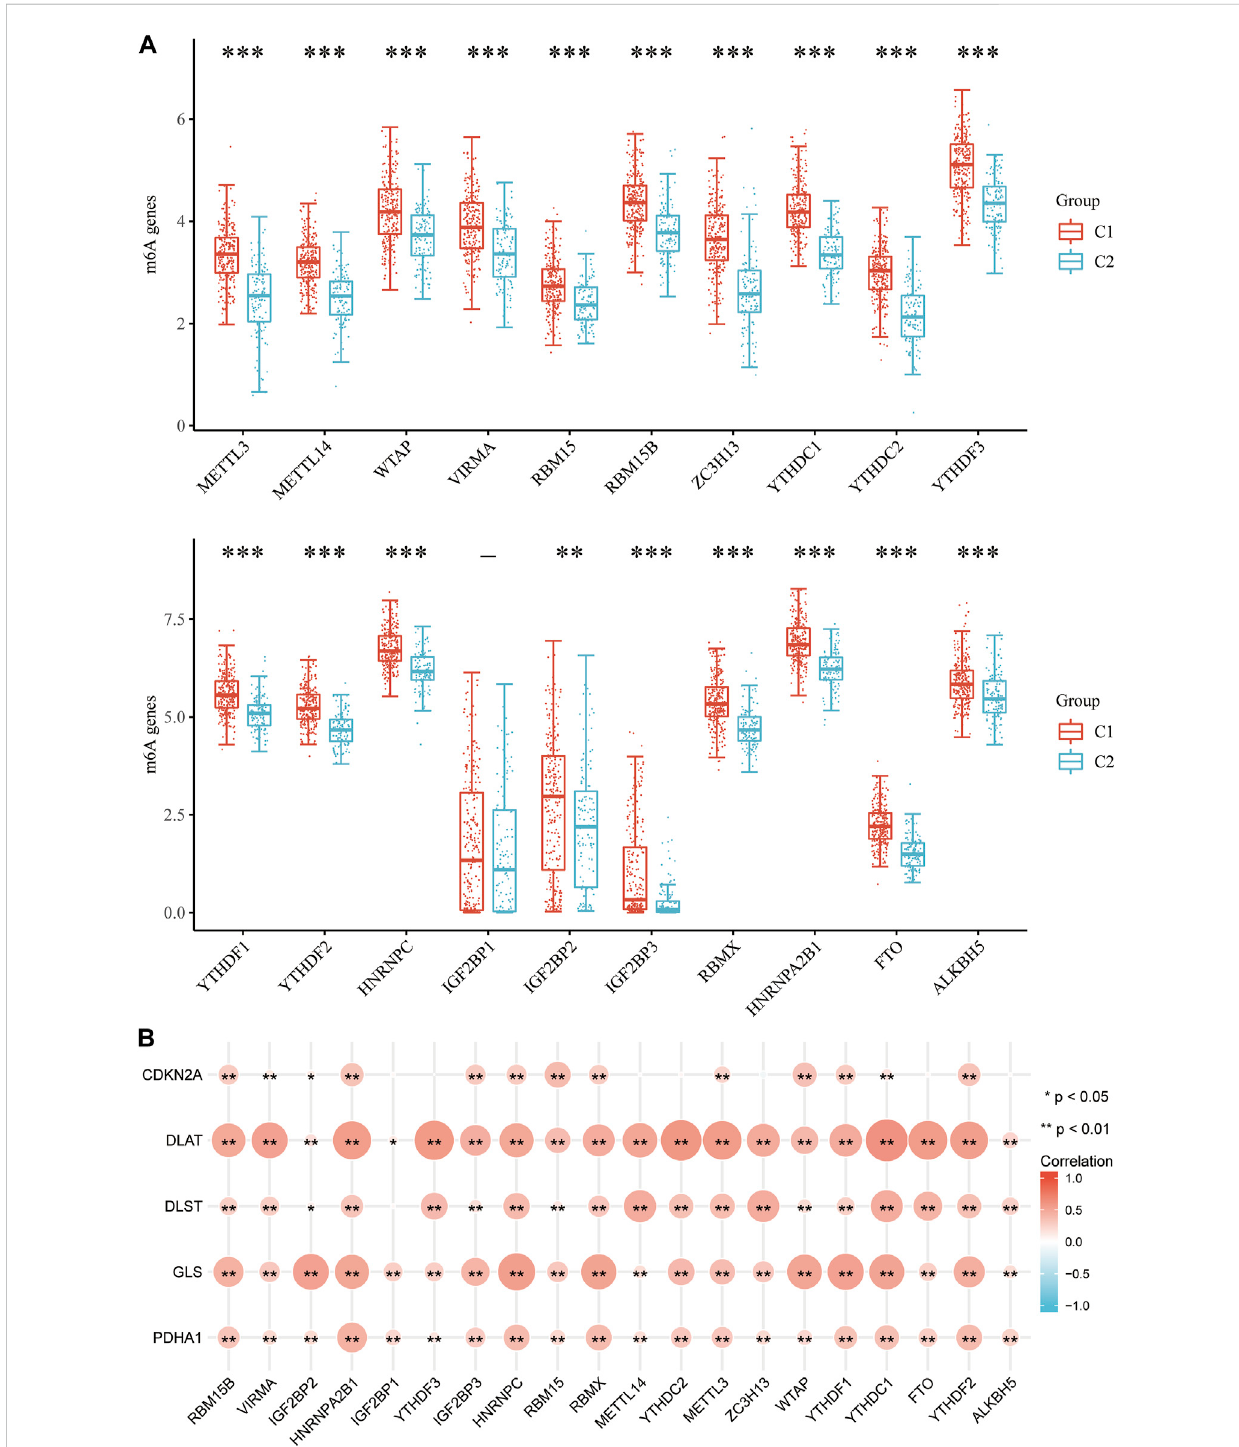
FIGURE 12 Correlation of CRG expressionand m6A-relatedgenes in HCC. (A) Differential expression of m6A-relatedgenes betweenthe C1 and C2 subgroups in HCC. (B) Analysis of the relationship between prognostic CRGs and m6A-related genes by TCGA-LIHC